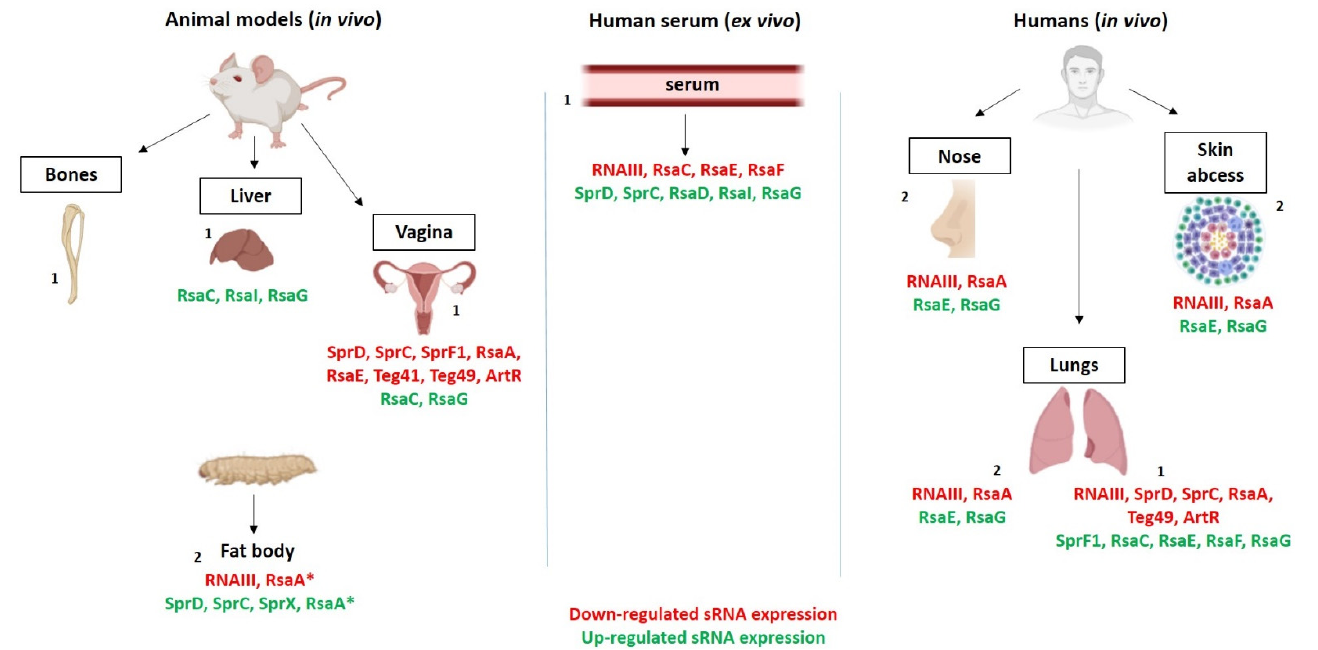
Figure 4. In vivo or ex vivo expressions of Staphylococcus aureus sRNAs contributing to the regulation of metabolism and/or virulence. In vivo or ex vivo expressions are compared to in vitro calibrators. Numbers 1 and 2 correspond to sRNA expressions obtained by RNA-Seq and RT-qPCR, respectively. * indicates in vivo down- or upregulation, according to the exponential or stationary growth phases [3,24,88,108,138,143].